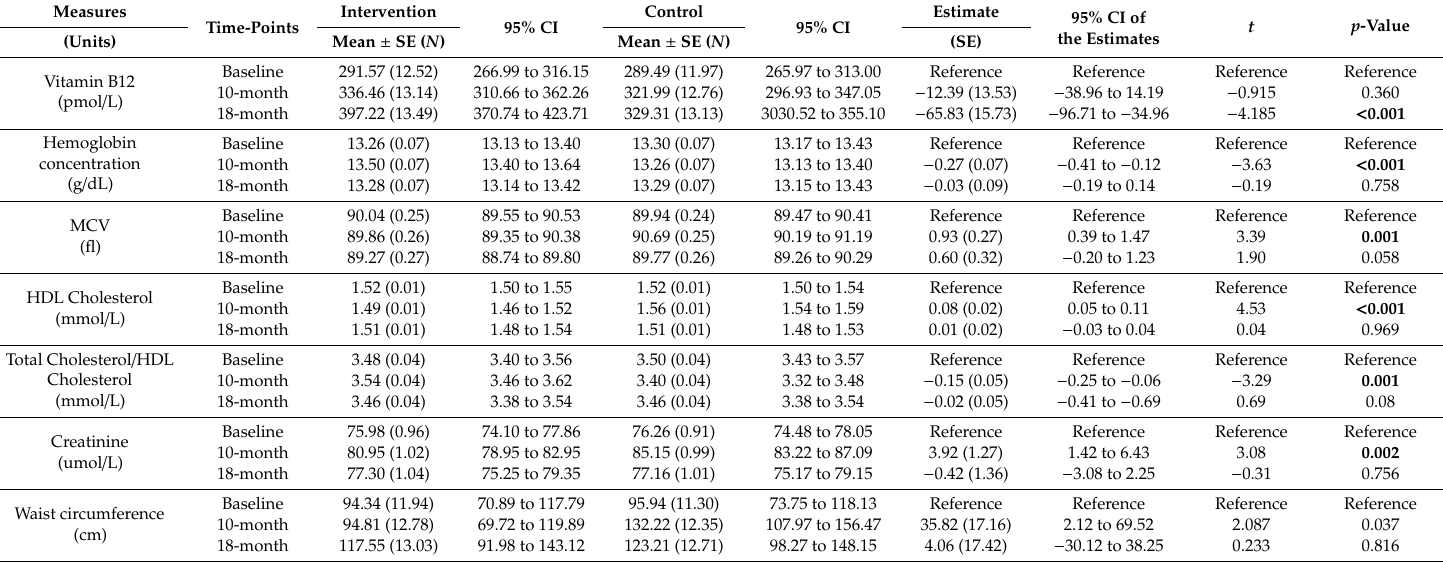
Table 4. Adjusted models for secondary outcomes: physiological